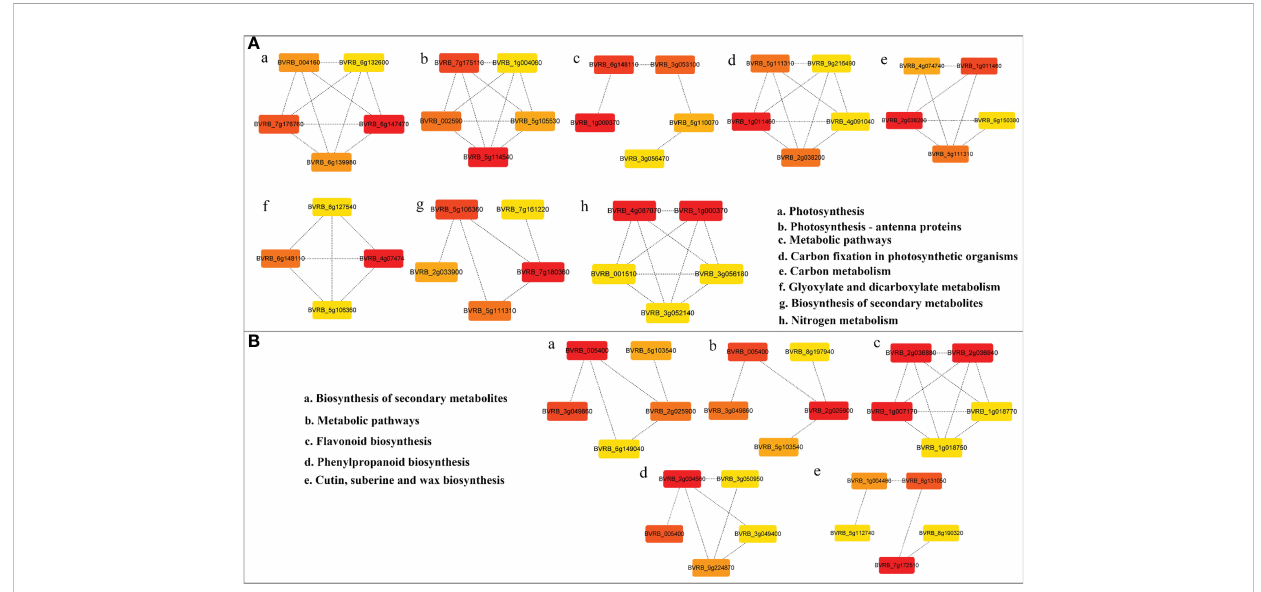
FIGURE 5 PPI network of primary and secondary metabolism of DEGs in sugar beet under LN stress. (A, B) PPI network diagram of downregulated and upregulated DEGs, respectively. Proteins are represented as nodes, and interactions are represented as edges. The color of the proteins indicates the strength of the protein interactions; the redder the color, the stronger the interactions. Only pathways with categories in error incidence rate (FDR) <0.01 were considered (Supplementary Table 4). PPI, protein − protein interaction; DEGs, differentially expressed genes; FDR, false discovery